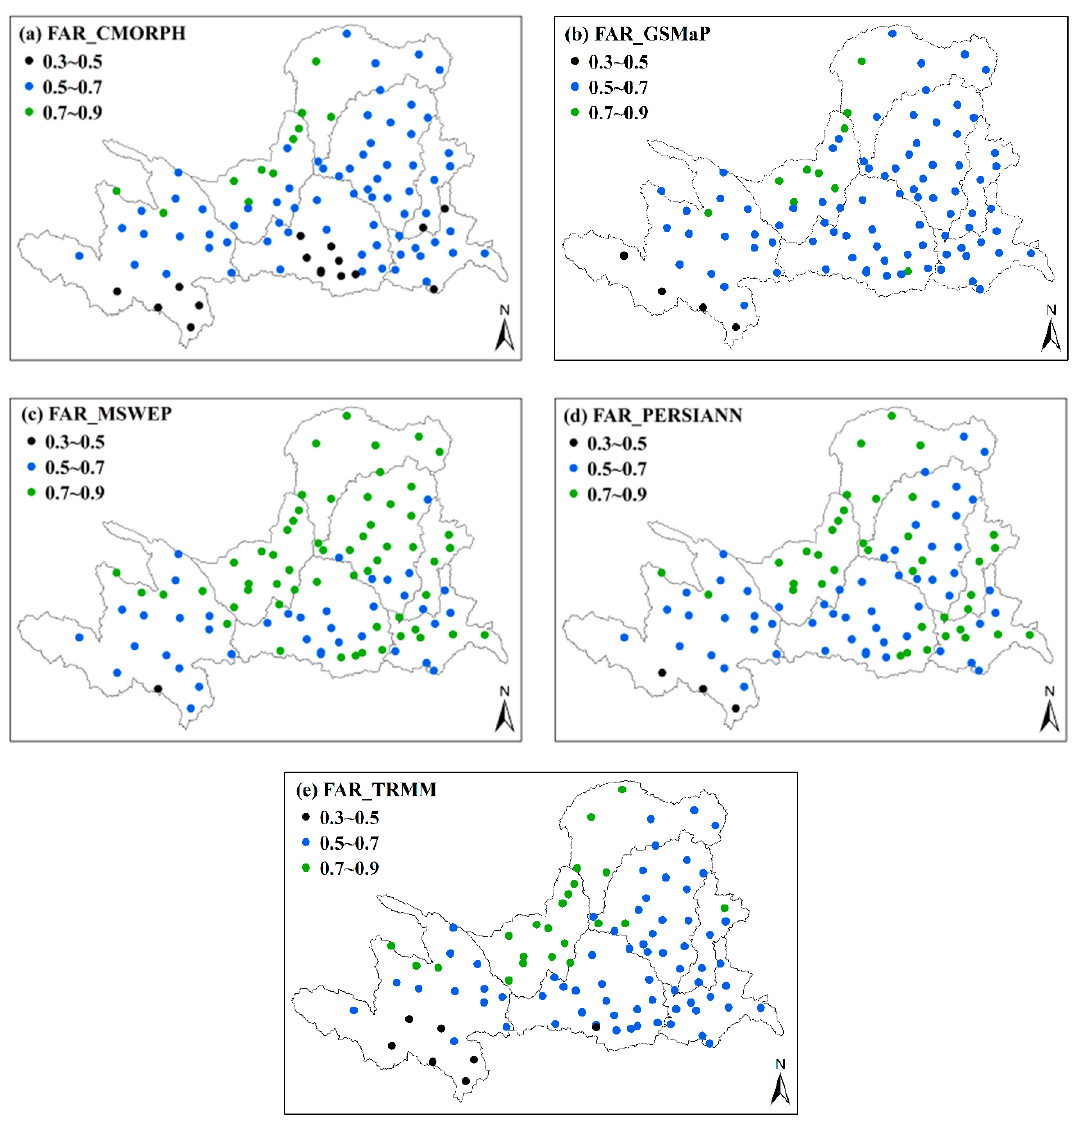
Figure 9. Spatial pattern of FAR (false alarm ratio).